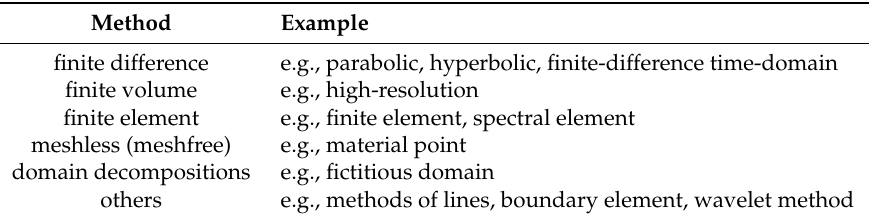
Table 1. Solution methods of numerical partial differential equations